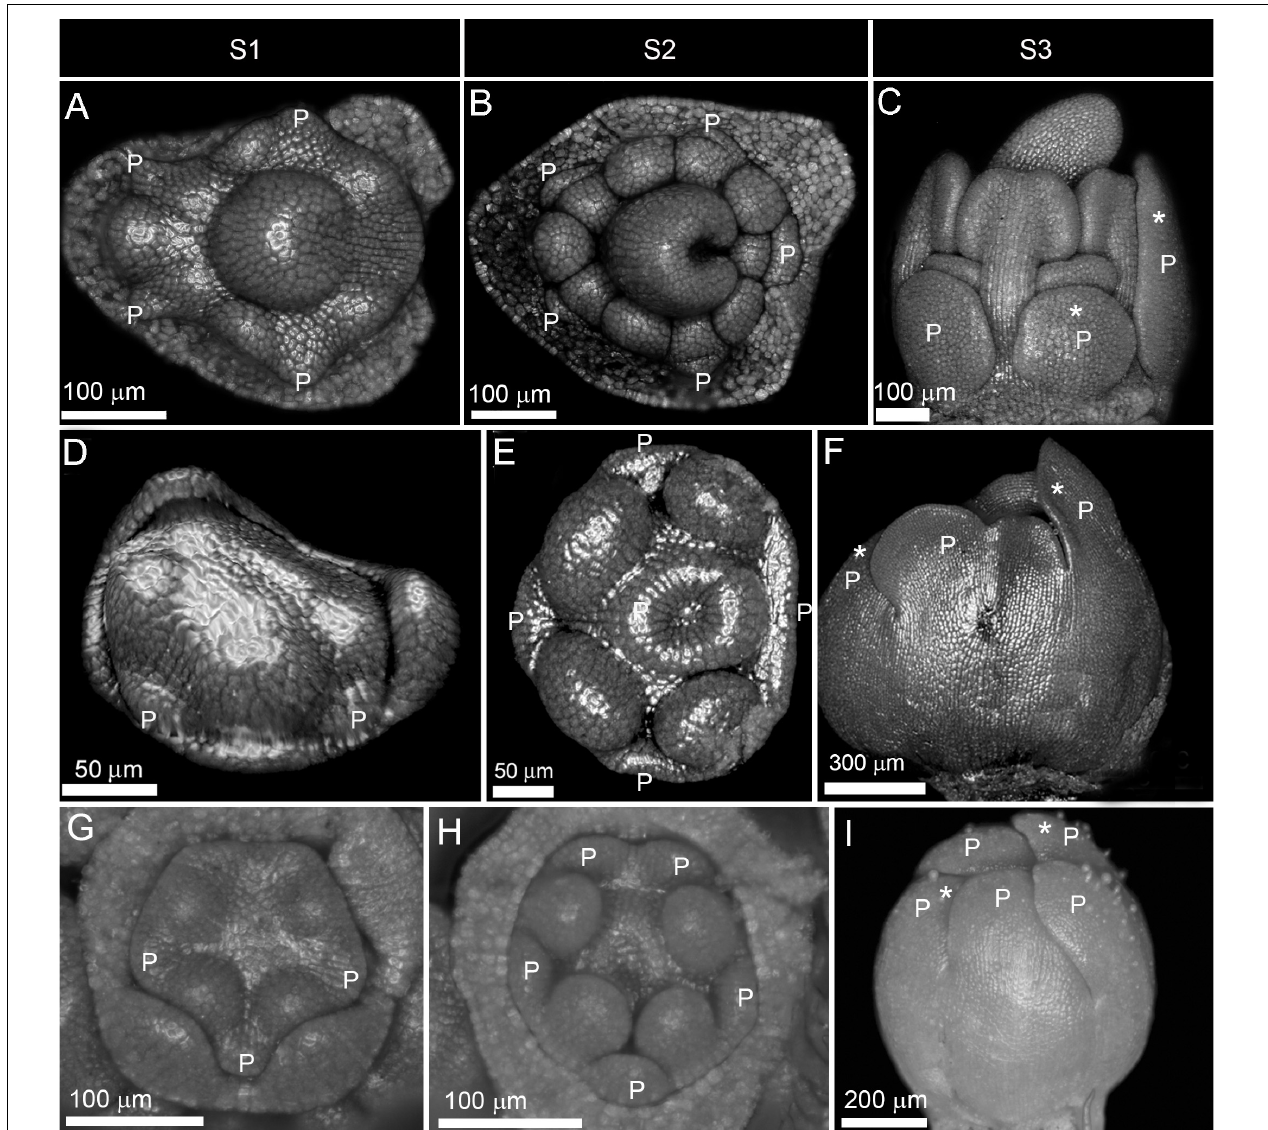
FIGURE 4 | Double change of symmetry in zygomorphic corollas. (A–I) Non-simultaneous initiation followed by synchronous enlargement and asynchronous differentiation causing a double shift in symmetry in Astragalus compactus from Fabaceae (A–C) , Rhyncocorys elephas from Orobanchaceae (D–F) , and Ziziphora tenuior from Lamiaceae (G–I) . P: petal, S1: initiation phase, S2: enlargement phase, S3: differentiation phase. Note the size difference between the largest and the smallest corolla members during asynchronous differentiation (shown by